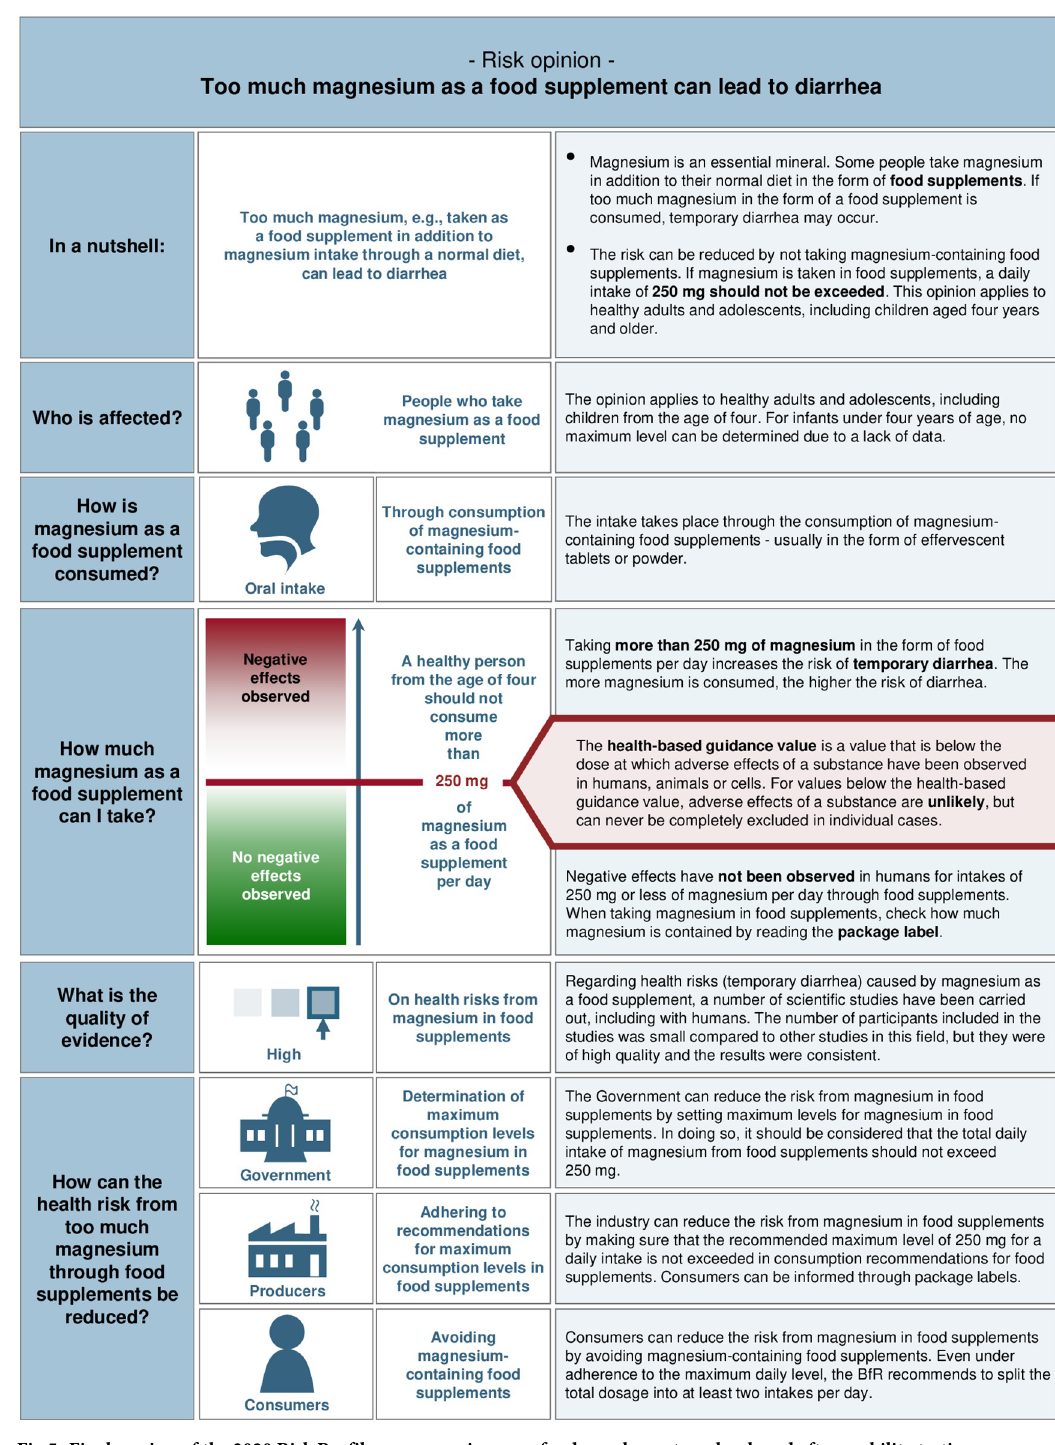
PLOS ONE | https://doi.org/10.1371/journal.pone.0266800 April 11,